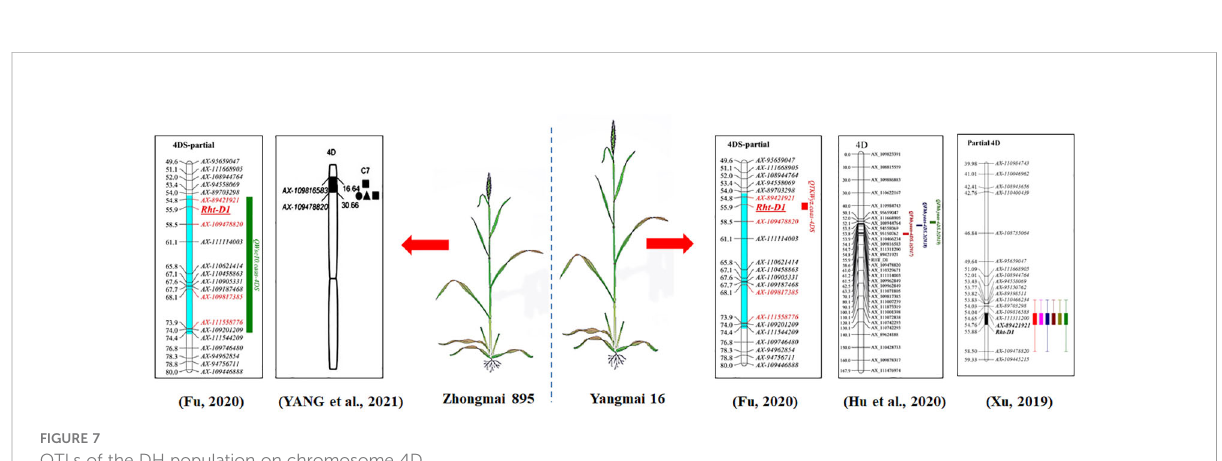
FIGURE 7 QTLs of the DH population on chromosome 4D.